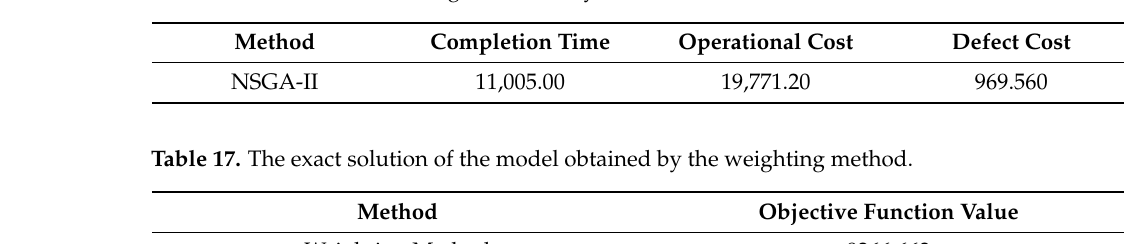
Table 16. The results of solving the model by NSGA-II.